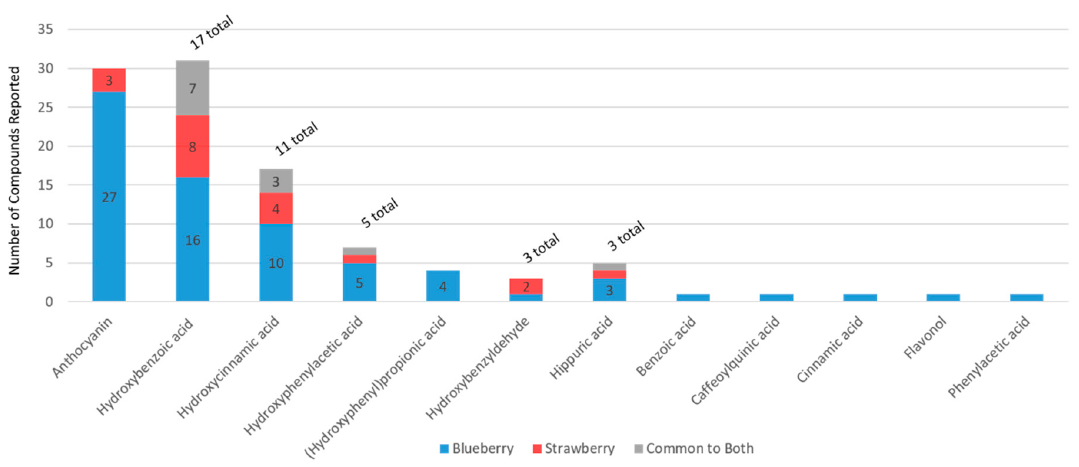
Figure 5. Number of human metabolites reported in intervention studies feeding blueberry or strawberry.